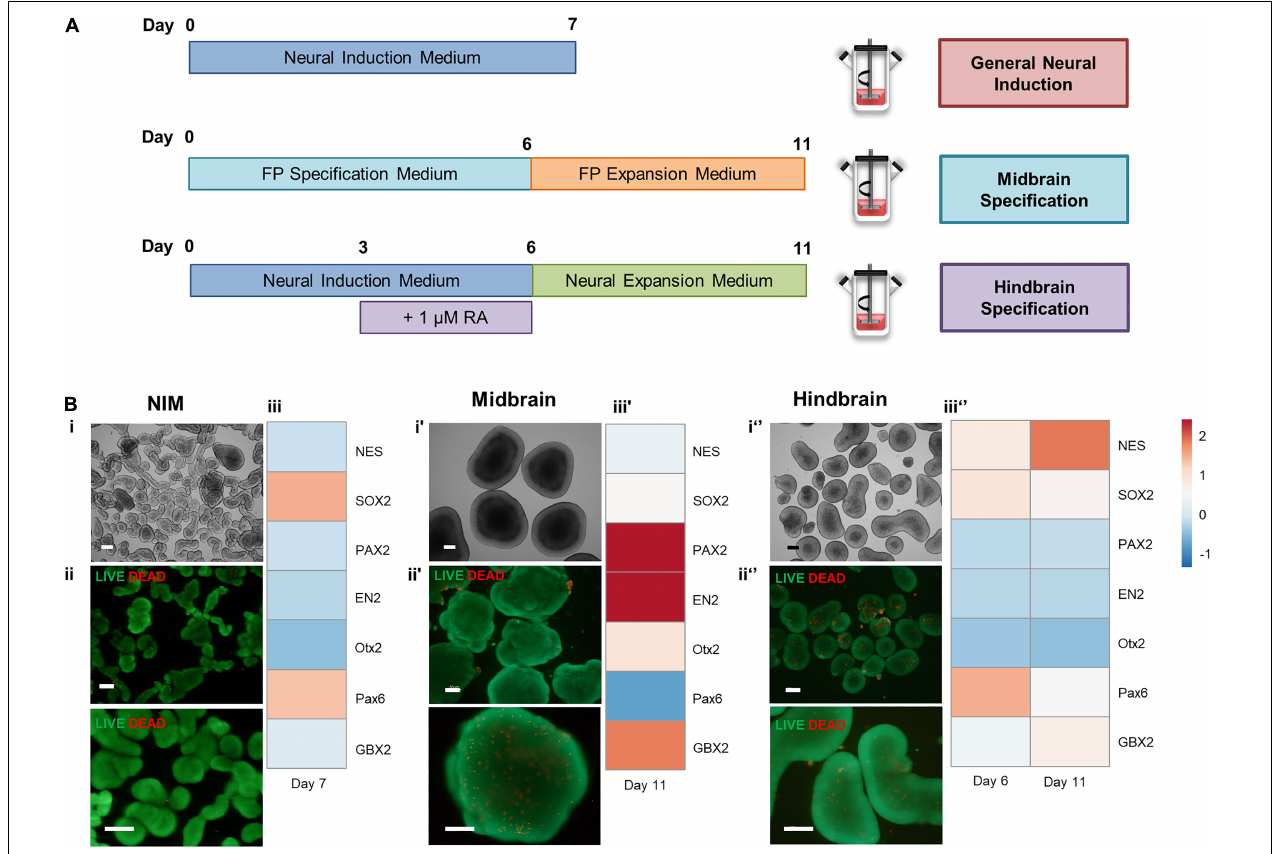
FIGURE 5 | (A) Schematic overview of different approaches to induce hiPSCs in spinner flasks. (B) Cell characterization after neural induction of hiPSCs in spinner flasks. Bright field images of 3D aggregates recovered at day 7 (i (cid:48) ) and day 11 (i,i (cid:48)(cid:48) ). LIVE/DEAD assay of FP progenitors recovered at day 7 (ii (cid:48) ) or day 11 (ii,ii (cid:48)(cid:48) ) . Green: calcein-AM; Red: Ethidium homodimer-1. Scale bars: 200 µ m. Hierarchical clustering illustrates relative expression levels of different genes for hiPSC and hiPSC-derived neural progenitors (iii,iii (cid:48) ,iii (cid:48)(cid:48) ) . NES , SOX2, PAX2, EN2, OTX2, PAX6 , and OTX2 were analyzed by qRT-PCR.